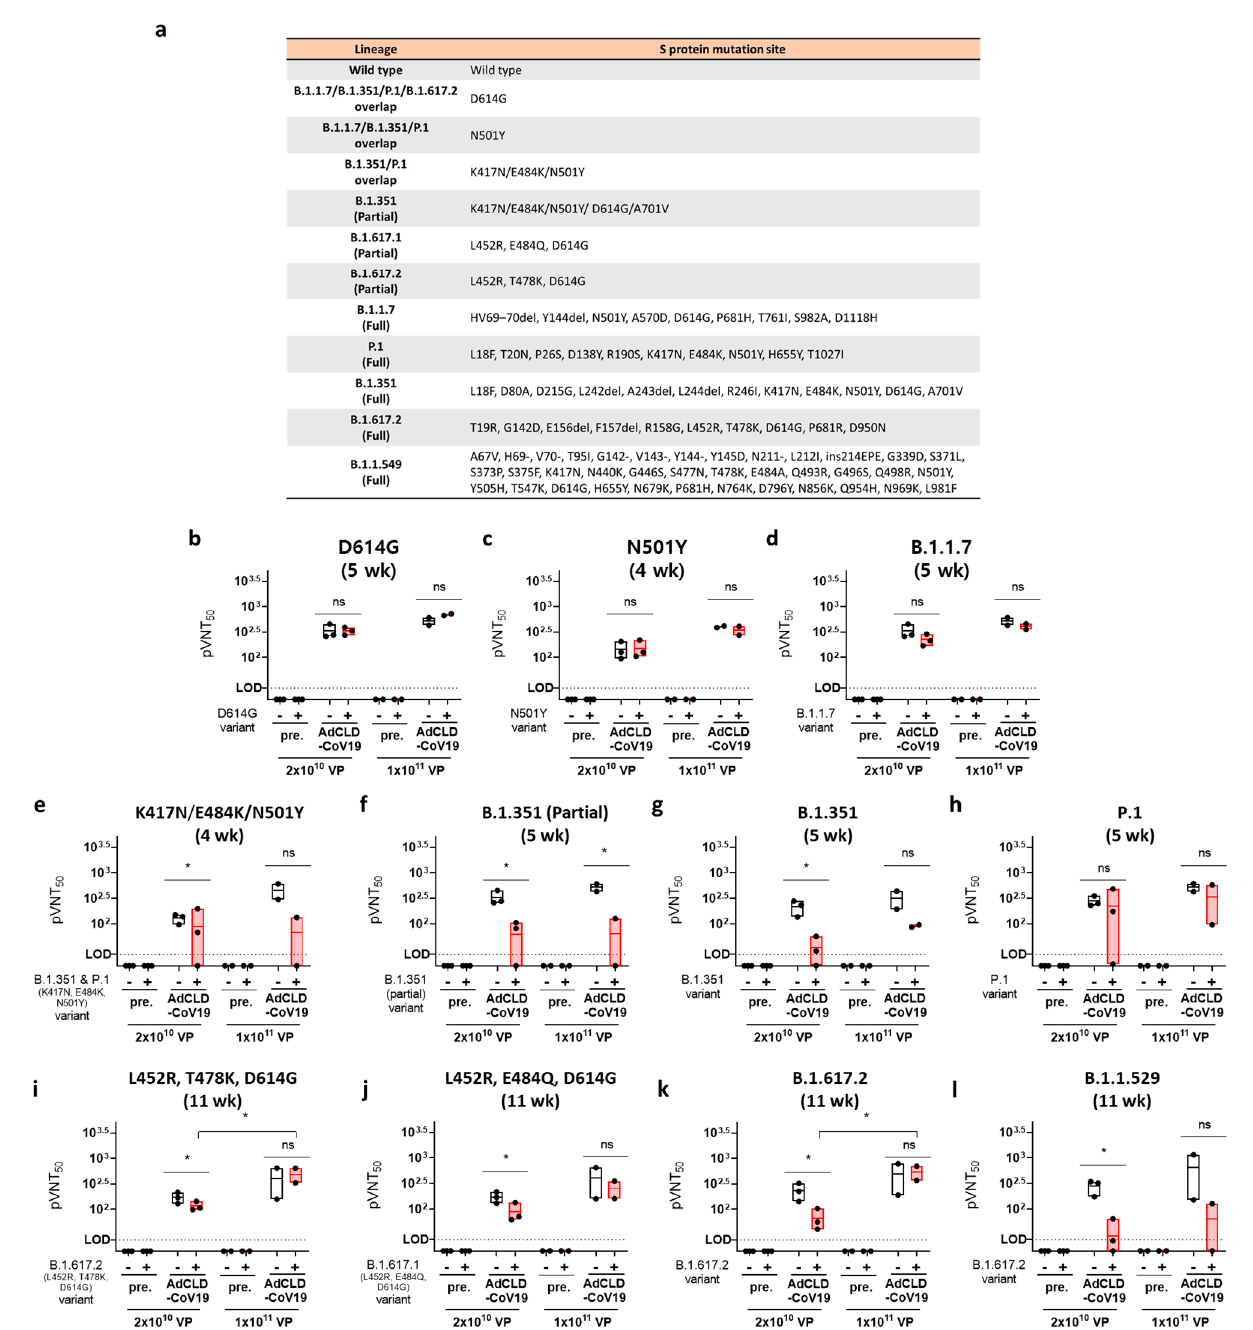
Figure 5. Evaluation of neutralization titer against SARS-CoV-2 variants of AdCLD-CoV19. ( a ) The pseudotyped lentivirus list table. ( b – l ) Sera from NHPs immunized for 4, 5, or 11 weeks with AdCLD-CoV19 (2 × 10 10 or 1 × 10 11 VP) were incubated with each variant pseudotyped lentivirus (1 × 10 6 TU/mL) for 1 h. The mixture was reacted with the HEK293T-hACE2 cell line (1 × 10 4 cells/well in 96-well plates), expressing luciferase for 2 days. The ‘ − ’ symbol in the graphs indicates a pseudovirus reflecting the Wuhan-Hu-1 wild-type, and a ‘+’ symbol indicates a pseudovirus reflecting each mutation. The reciprocal neutralizing titers on the pseudotyped lentivirus neutralization test at a 50 % pseudovirus neutralization titers (pVNT 50 ) are shown. All graphs are displayed with floating bar (min to max) boxes and mean values indicated by inner lines, with horizontal dashed lines representing the limit of detection (LOD). Two-tailed Student’s t -test was used for the analysis. *, p < 0.05; ns, not significant.